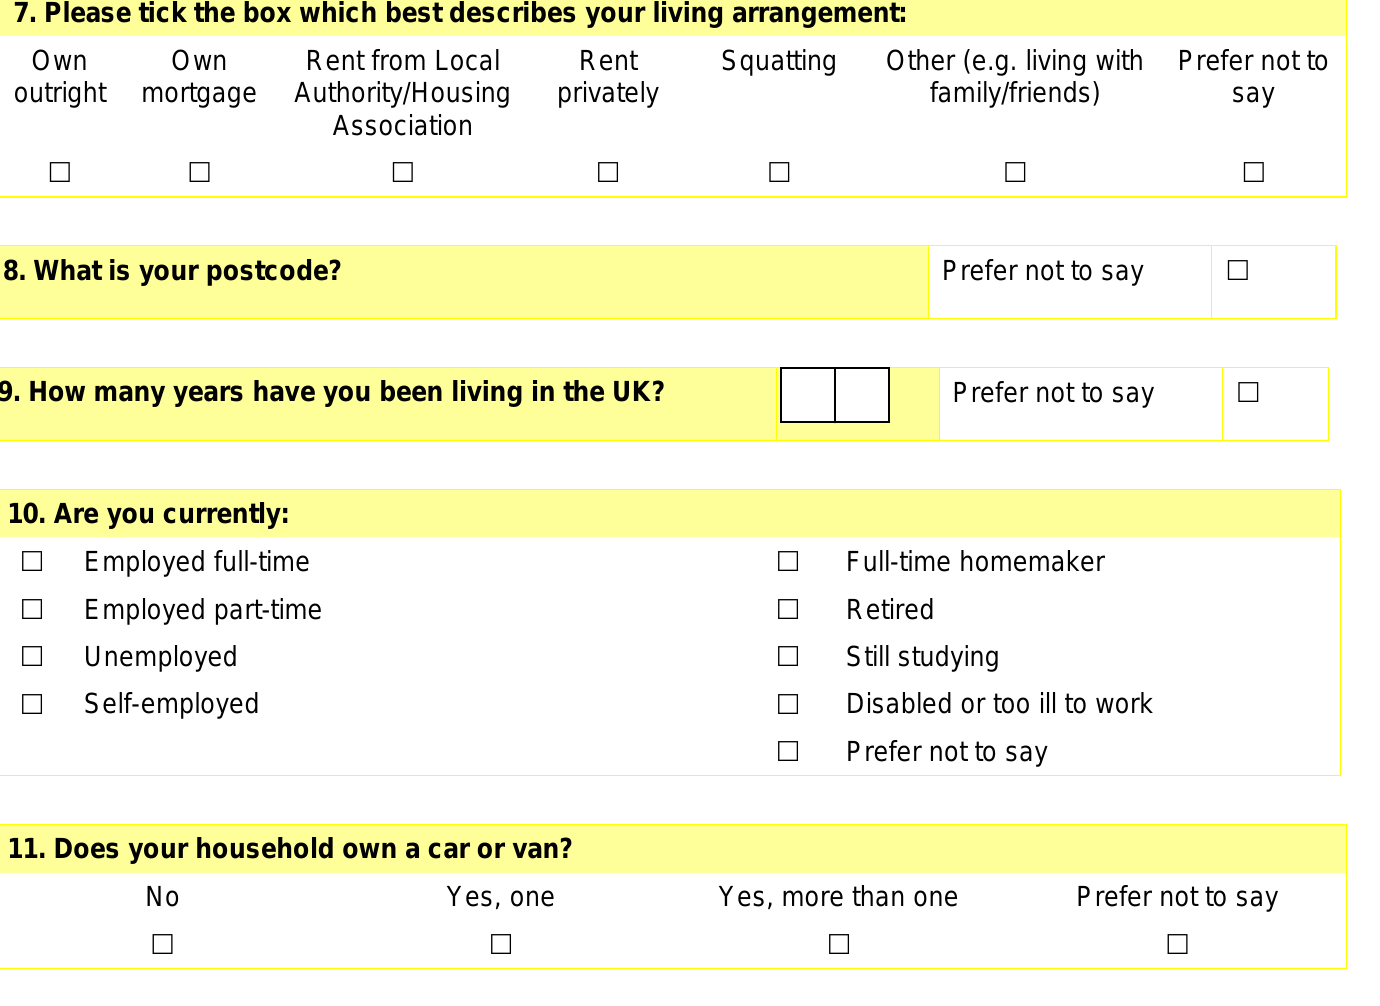
Cervical Cancer Awareness Measure Toolkit Version